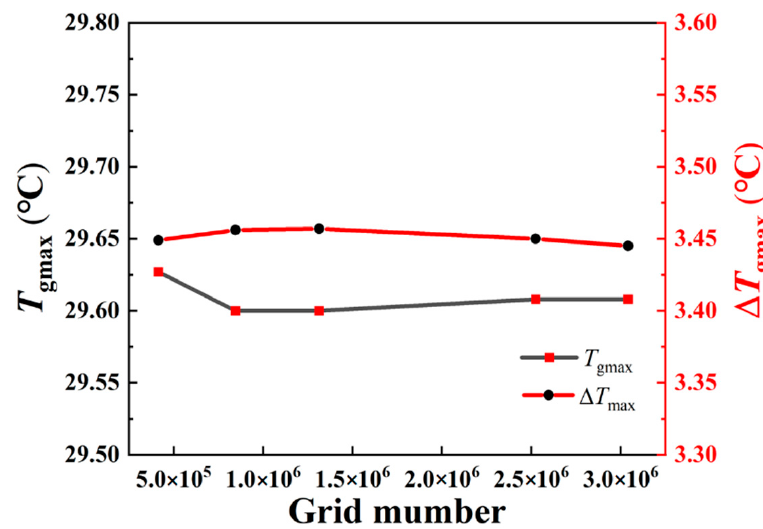
Figure 3. Grid independence verification.